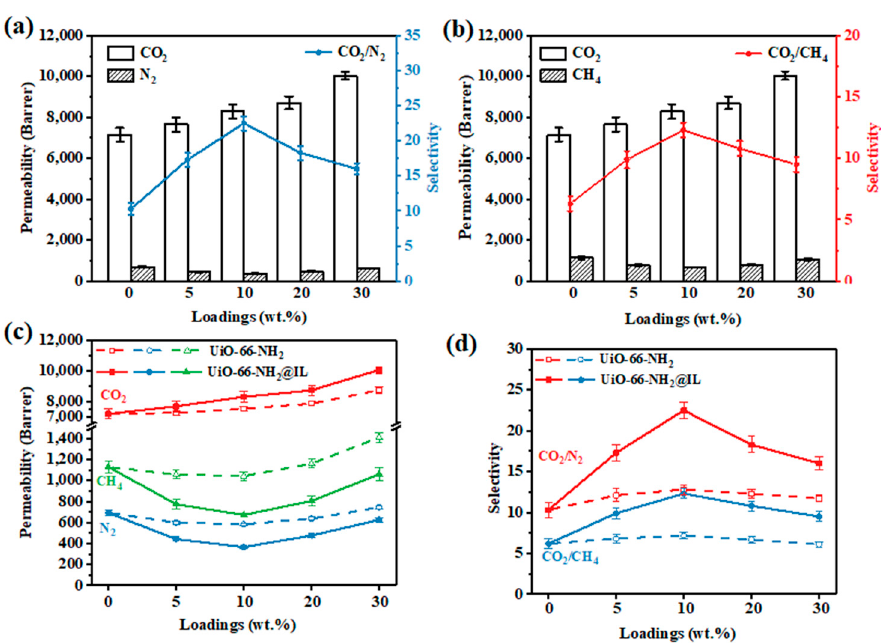
Figure 6. ( a ) CO 2 /N 2 separation property of UiO-66-NH 2 @IL/PIM-1 MMM; ( b ) CO 2 /CH 4 separation property of UiO-66-NH 2 @IL/PIM-1 MMM; ( c ) Pure gas permeabilities of MMM with different UiO-66-NH 2 or UiO-66-NH 2 @IL loadings; ( d ) CO 2 /N 2 and CO 2 /CH 4 selectivities of MMMs with different UiO-66-NH 2 or UiO-66-NH 2 @IL loadings.